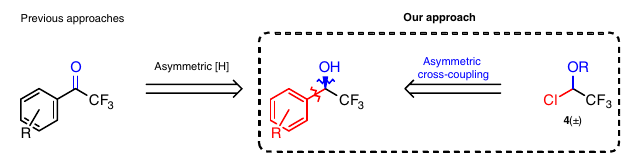
a Reactions were performed with 4b as a starting material on 0.06mmol scale using 1.3 eqiv. PhSi(OMe) 3 , 2.5 eqiv. tetrabutylammonium triphenyldi fl uorosilicate (TBAT), 10% NiCl 2 ·glyme, 11% ligand 7a in N , N -dimethylacetamide (DMA), at room temperature with blue LED light irradiation b NMR yields vs. internal standard c After